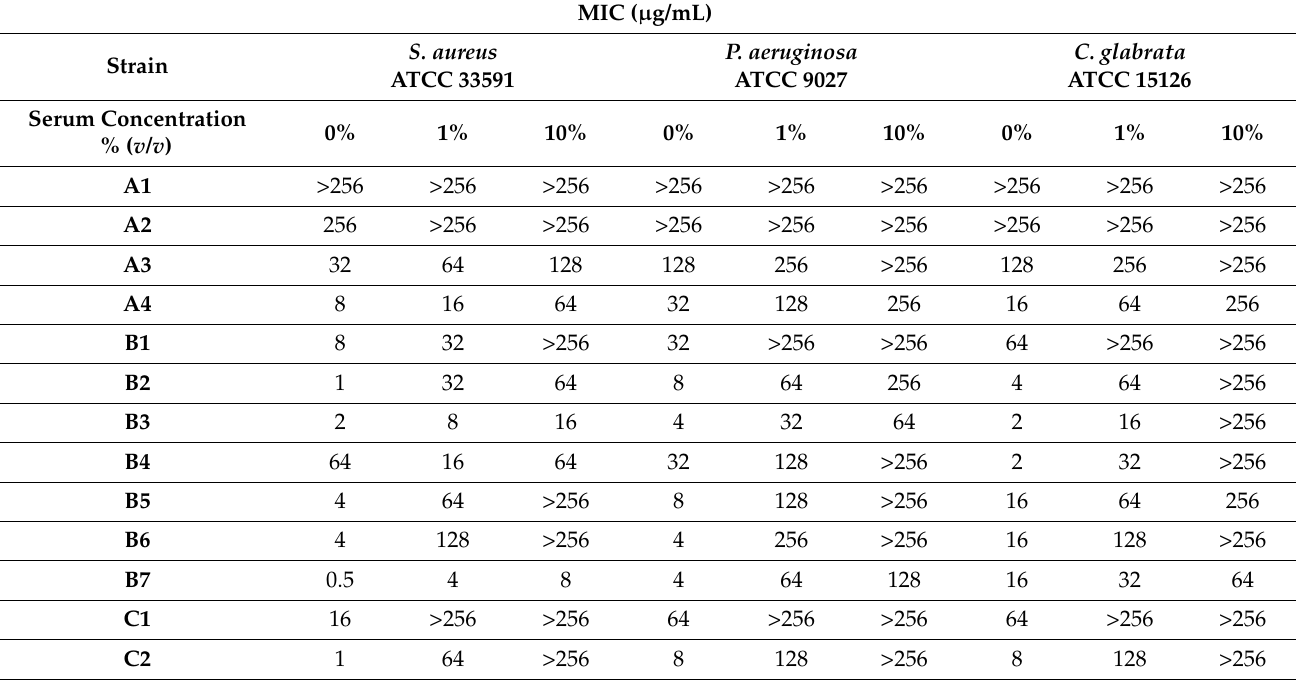
Table 4. Antimicrobial activity of lipopeptides in the presence of human serum. MIC ( µ g/mL) S. aureus P. aeruginosa ATCC 33591 ATCC 9027